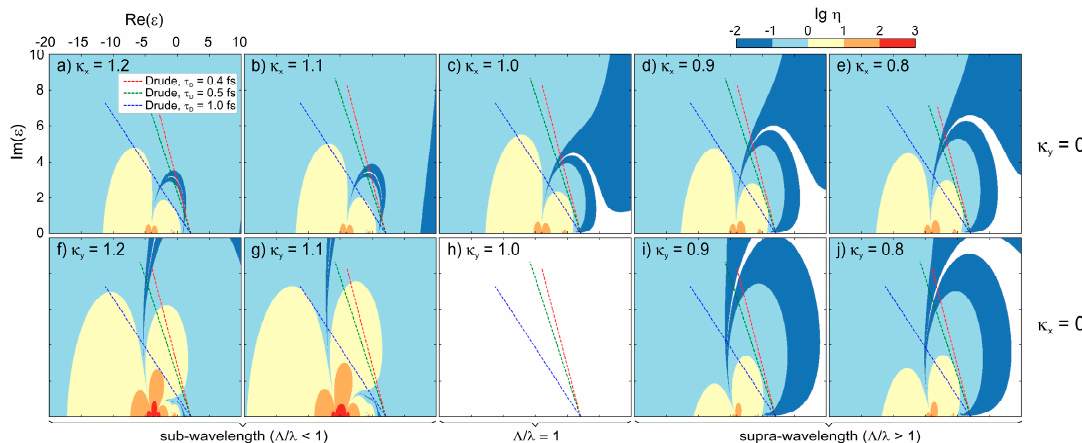
Figure 7. Sipe efficacy factor, η , presented as a function of the complex dielectric permittivity, ε [Re( ε ), Im( ε )]. For the calculations, polarization was oriented towards the x -direction. In the first line ( a – e ), η was computed for λ / Λ y = κ y = 0 and κ x was systematically varied. In the second line ( f – j ), η was computed for λ / Λ x = κ x = 0 and κ y was systematically varied. The white zones indicate an efficacy factor smaller than 10 − 2 . The false-color scale is the same for all the sub-figures: The cold color indicates an efficiency factor lower than 1, and the warm color indicates an efficiency factor greater than 1. The dashed lines correspond to the density-dependent excited dielectric permittivity, ε *, of fused silica upon excitation computed using the Drude model (see Equation (1)). The impact of different Drude damping times, τ D , are represented and the optical mass was kept at m opt = 0.49.